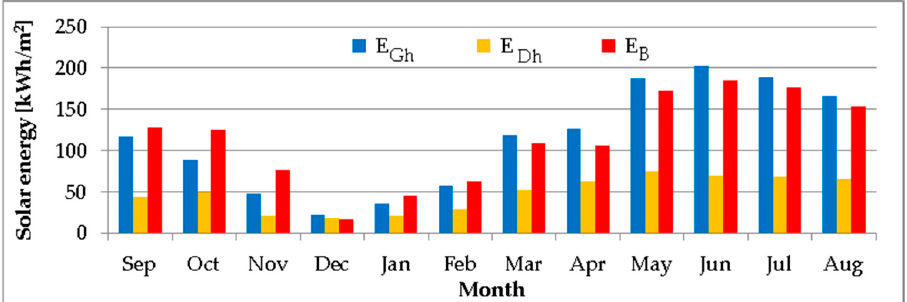
Figure 7. Monthly global horizontal ( E Gh ), diffuse horizontal ( E Dh ) and direct ( E B ) solar energy measured in Brasov between September 2021–August 2022.